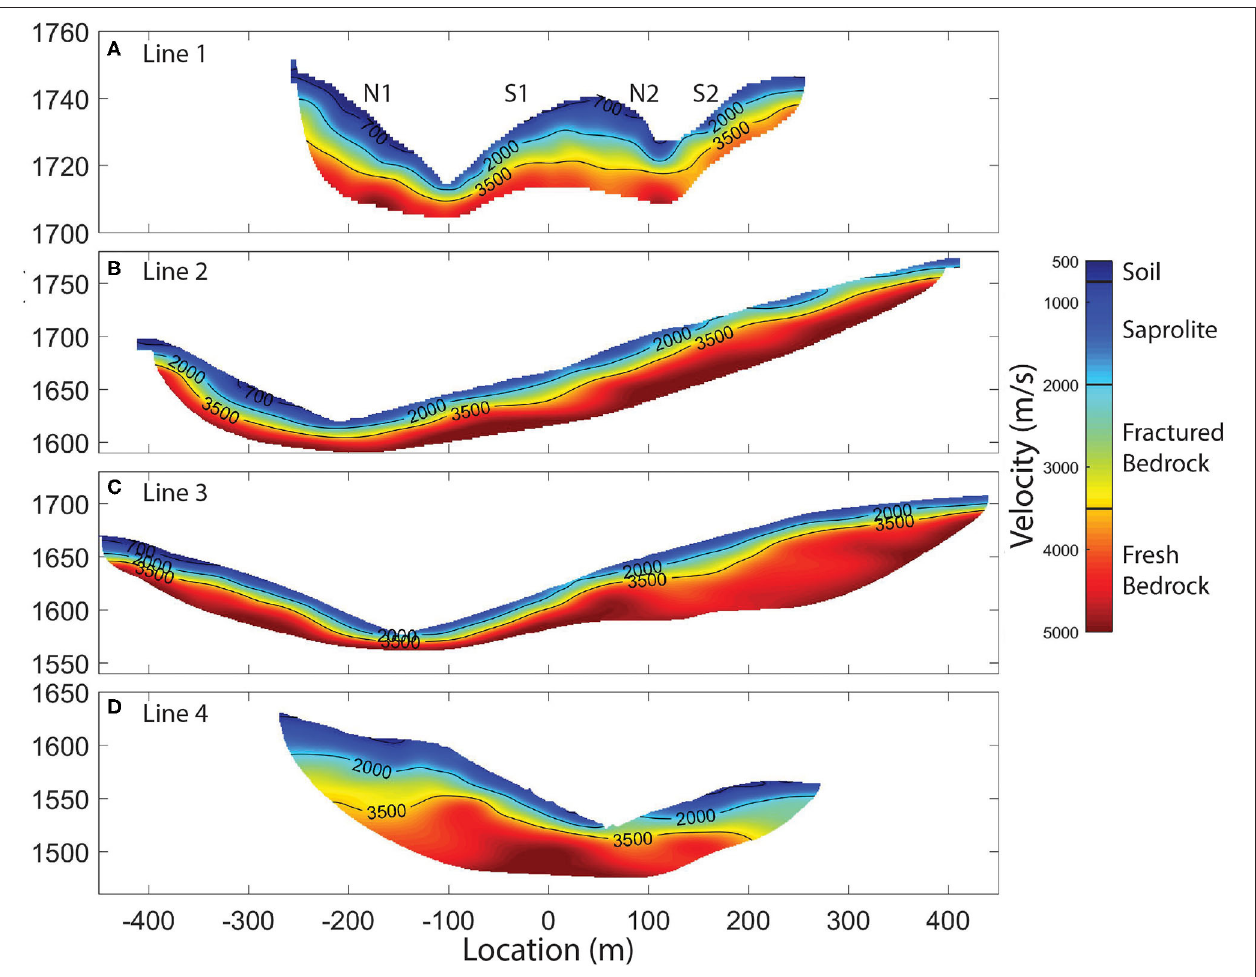
Table 1 . Line 1 (A) is vertically exaggerated by 3 times while all the other profiles have no vertical exaggeration. (B) Line 2, (C) Line 3, and (D) Line